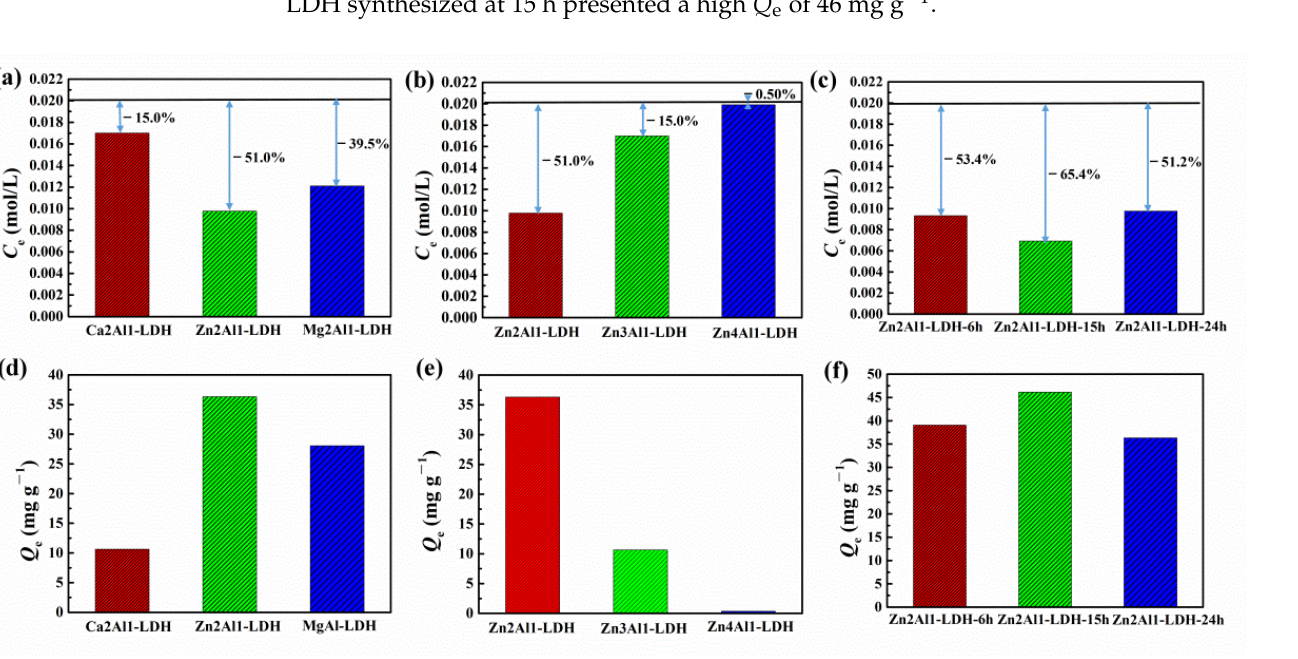
Figure 10. The equilibrium chloride concentration C e (mol/L) ( a ) Ca2Al1-LDH, Zn2Al1-LDH and Mg2Al1-LDH; ( b ) Zn2Al1-LDH, Zn3Al1-LDH and Zn4Al1-LDH; ( c ) Zn2Al1-LDH-6h, Mg2Al1-LDH; ( b ) Zn2Al1-LDH, Zn3Al1-LDH and Zn4Al1-LDH; ( c ) Zn2Al1-LDH-6 h, Zn2Al1-LDH- Zn2Al1-LDH-15h and Zn2Al1-LDH-24h and amount of chloride adsorption at the equilibrium Q e 15 h and Zn2Al1-LDH-24 h and amount of chloride adsorption at the equilibrium Q e (mg · g − 1 ) of (mg·g − 1 ) of different LDH samples in 0.02 mol/L NaCl ( d ) Ca2Al1-LDH, Zn2Al1-LDH and different LDH samples in 0.02 mol/L NaCl; ( d ) Ca2Al1-LDH, Zn2Al1-LDH and Mg2Al1-LDH; Mg2Al1-LDH; ( e ) Zn2Al1-LDH, Zn3Al1-LDH and Zn4Al1-LDH; ( f ) Zn2Al1-LDH-6h, ( e ) Zn2Al1-LDH, Zn3Al1-LDH and Zn4Al1-LDH; ( f ) Zn2Al1-LDH-6 h, Zn2Al1-LDH-15 h and Zn2Al1-LDH-15h and Zn2Al1-LDH-24h. Zn2Al1-LDH-24